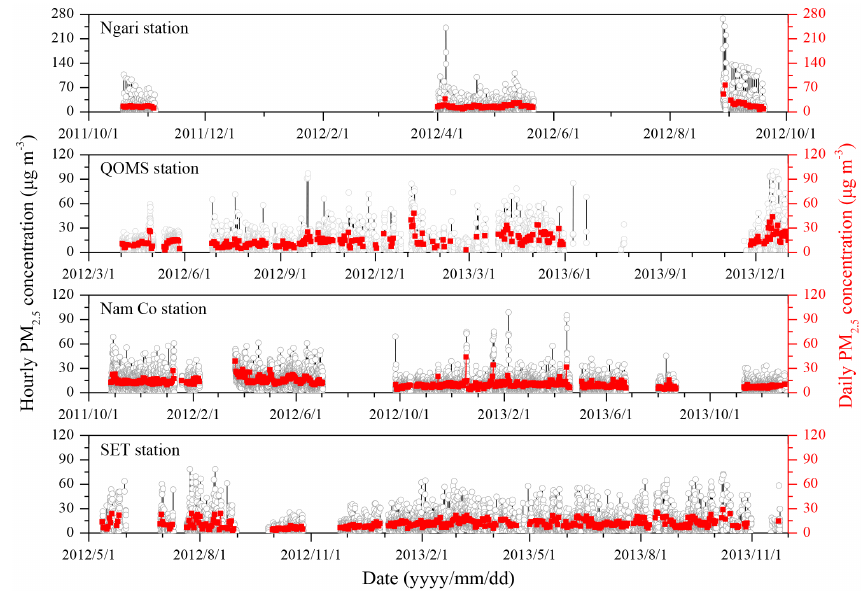
Figure 3. Hourly and daily mean concentrations (µgm − 3 ) of PM 2 . 5 at the Ngari station (October 2011–October 2012), the QOMS station (March 2012–December 2013), the Nam Co station (October 2011–December 2013) and the SET station (May 2011–December 2013) in the HTP. Periods with no data were due to power supply problems or equipment breakdown. A daily mean was calculated only when at least eight hourly means were available during that day.